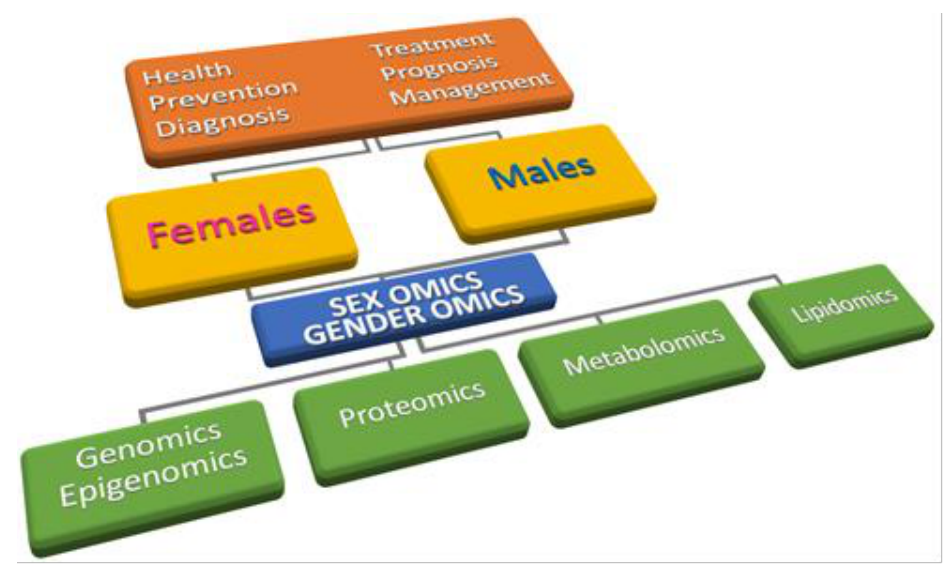
Figure 8. Proposed sex-omics / gender-omics strategy for research and clinical approach to diseases.